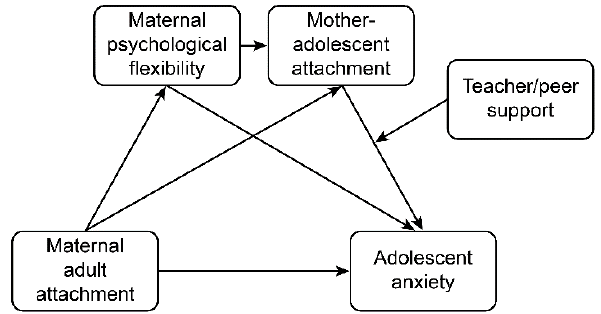
Figure 1. Diagram of the hypotheses and model.